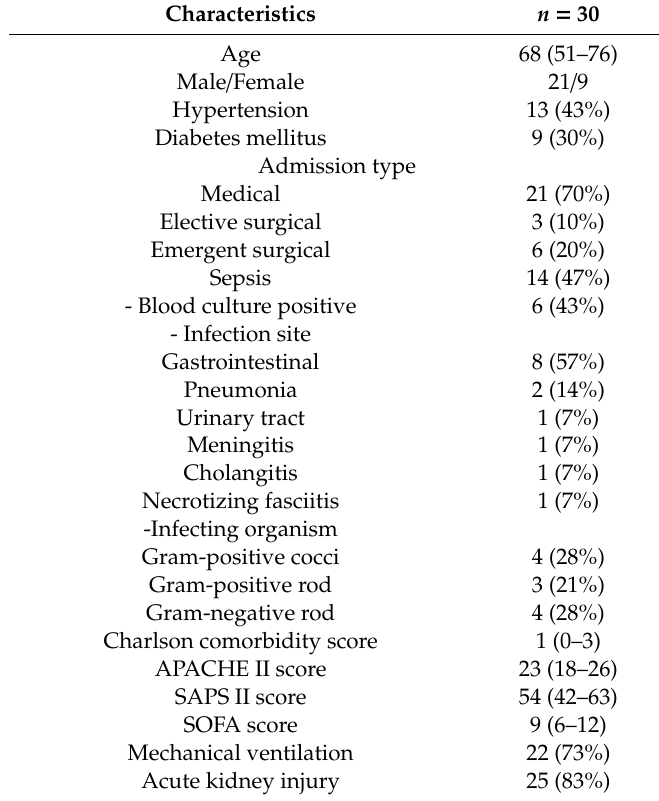
Table 1. Baseline patient